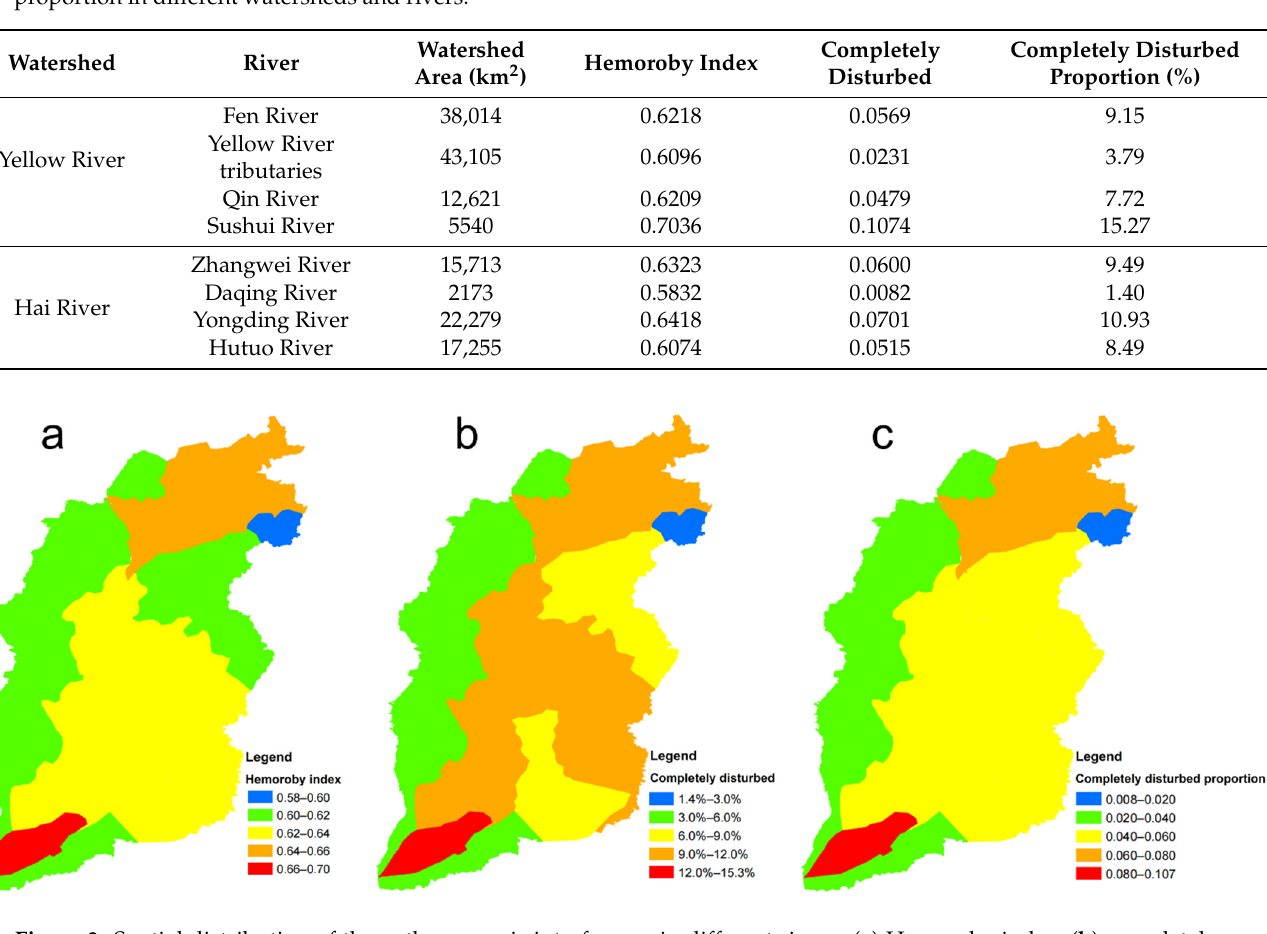
Figure 3. Spatial distribution of the anthropogenic interference in different rivers. ( a ) Hemoroby index; ( b ) completely disturbed; ( c ) completely disturbed proportion. Table 2. Anthropogenic interference levels, including Hemoroby index, completely disturbed, and completely disturbed proportion in different watersheds and rivers.